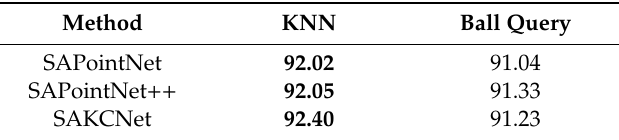
Table 5. Accuracies (%) of object classification results on the ModelNet40 dataset with di ff erent local neighborhood searching